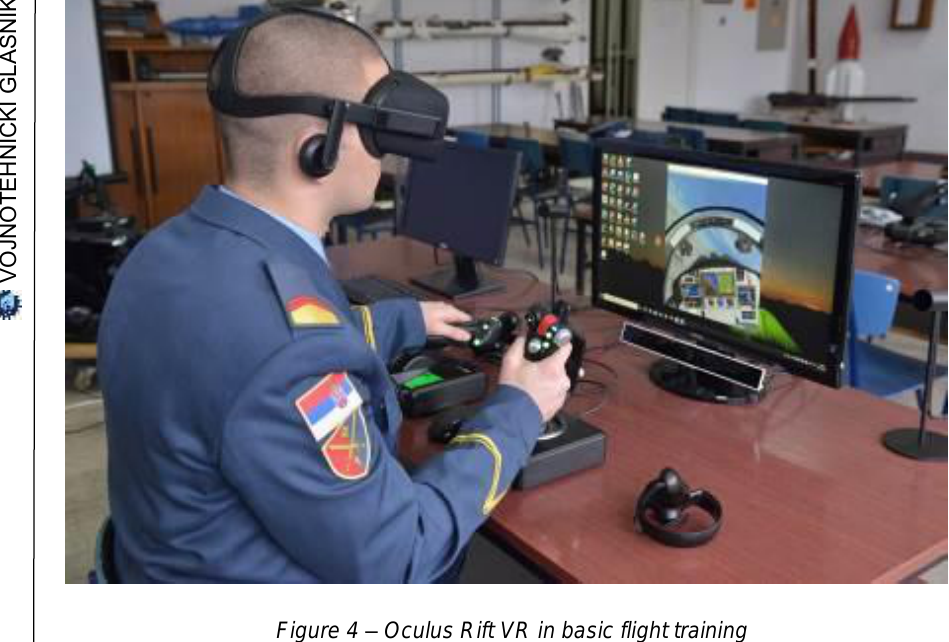
Figure 4 – Oculus Rift VR in basic flight training Рис. 4 – Oculus Rift VR в основной летной подготовке Слика 4 – Oculus Rift VR у основној летачкој